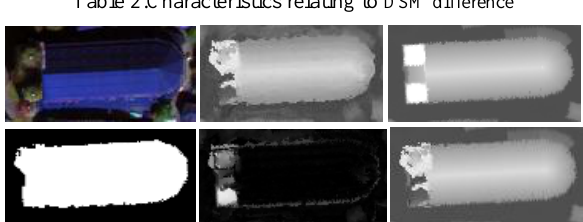
Figure 8.Visual evaluation of obtained results. Cross sections of Worldview-2 DSM (Top), Cross sections of Lidar DSM (Middle), Cross sections of updated DSM (Bottom). Code 1: unchanged areas, Code 2: changed areas.